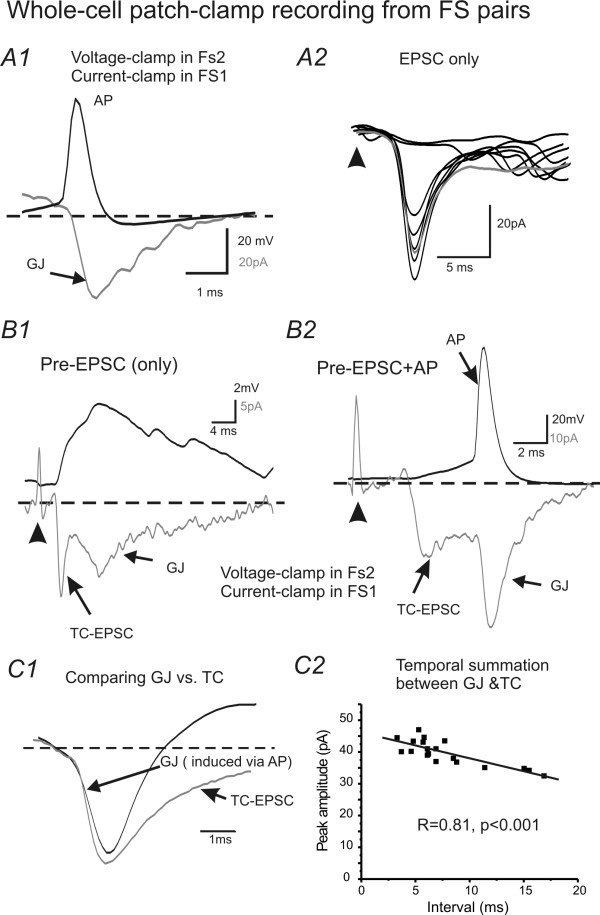
Mechanisms underlying TC and EPJP interaction: temporal summation of EPJP and TC. A1) Current-clamp recording of AP (black trace) and voltage-clamp recording of EPJC (gray trace) in a FS pair from brain slice. A2) Voltage-clamp recording of TC -EPSCs in a FS cell. B1&B2) A subthreshold (B1) and suprathreshold (B2) TC induced response in a presynaptic FS cell (black, current clamp) and its postsynaptic responses in another FS cell (gray, voltage-clamp), respectively. C1) Normalized conductance curve of EPJP (induced by single AP) and TC-EPSC in real FS neurons (averaged from 6 cells). C2) Temporal properties of TC-EPSC and EPJP summations measured in FS pairs. Solid line: linear fitting (R = 0.81, p < 0.001).